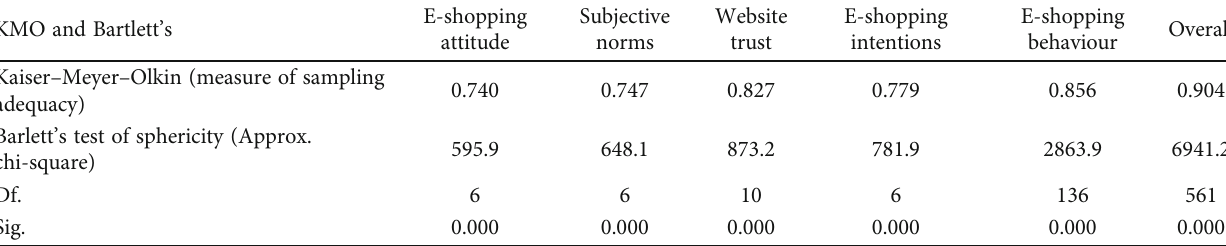
Table 9: KMO and Bartlett ’ s tests.